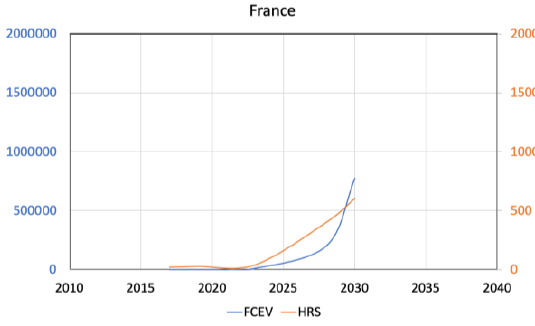
Fig. 3. The number of HRS and FCEVs in France (2017–2030)